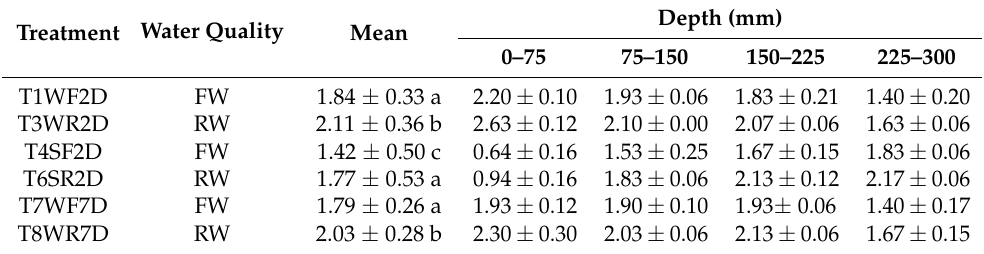
Table 4. Descriptive statistics of soil salinity (EC) between two different water qualities, six irrigation methods, and two irrigation scenarios (each value being a mean of three replicates ± standard deviation). Treatment Water Quality